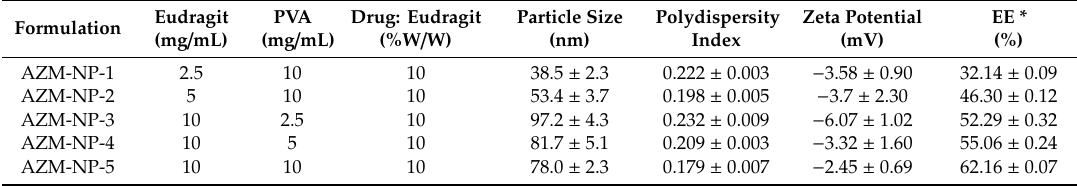
Table 1. Preparative characteristics and physicochemical properties of the di ff erent formulations